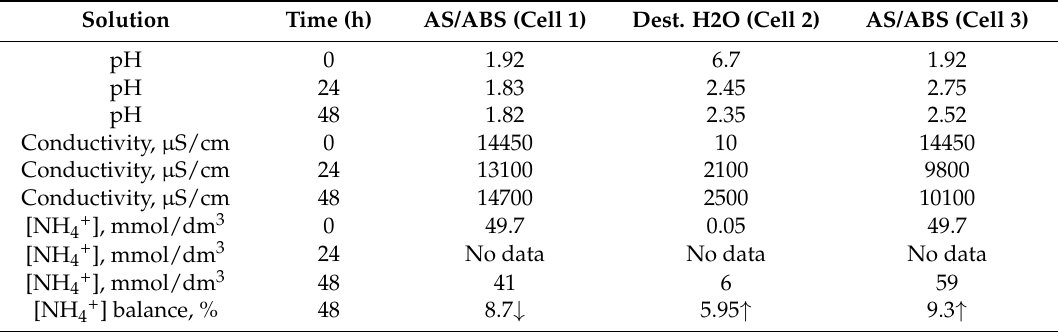
Table 1. Measured pH, conductivity and ammonium concentration in the cells of an electrodialysis stack. A cationic monovalent membrane is placed between cells 1 and 2. An anionic monovalent membrane is placed between cells 2 and